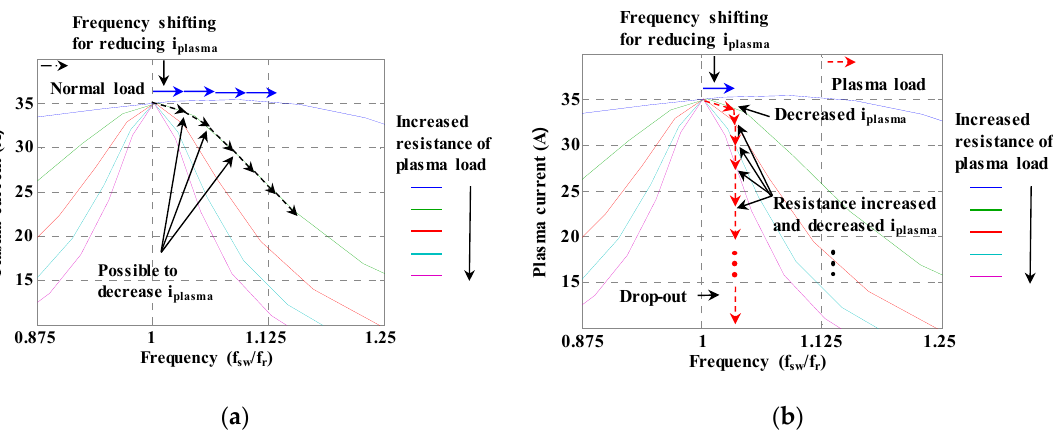
Figure 2. Description diagram of plasma drop-out: ( a ) frequency control method in resistive load; ( b ) frequency control method in plasma load.